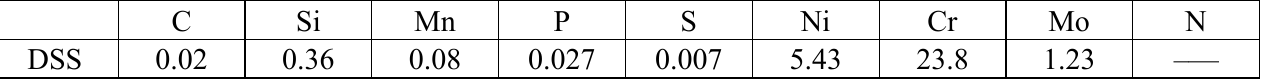
Table 1. Chemical composition of duplex stainless steel (bal. Fe).